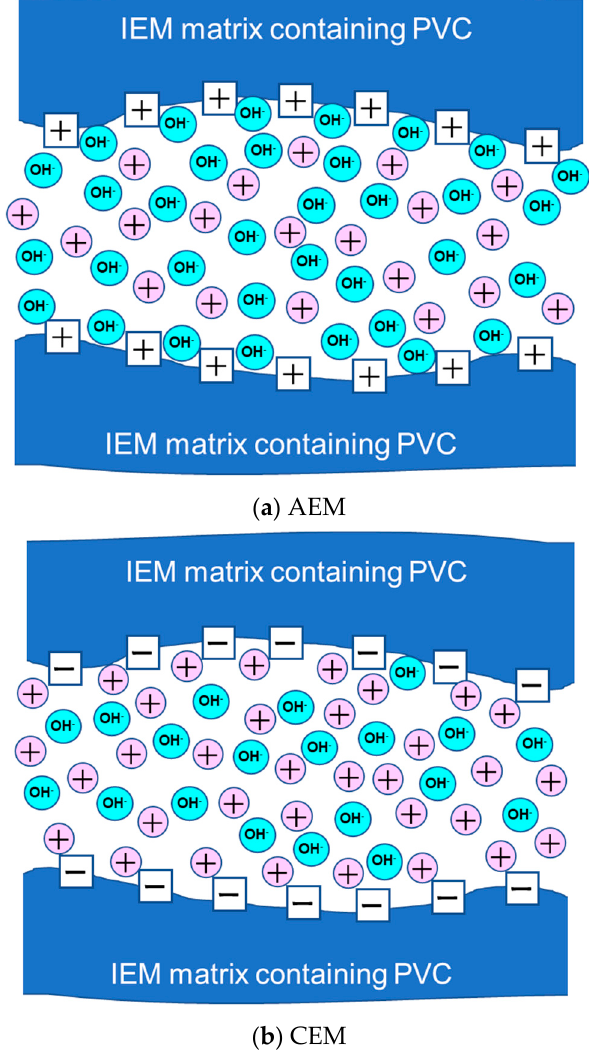
Figure 12. Schematic diagram of the distribution of ions inside IEMs containing PVC. ( a ) AEM; ( b ) CEM.